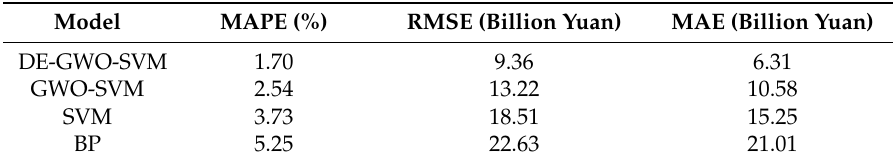
Table 4. The calculation